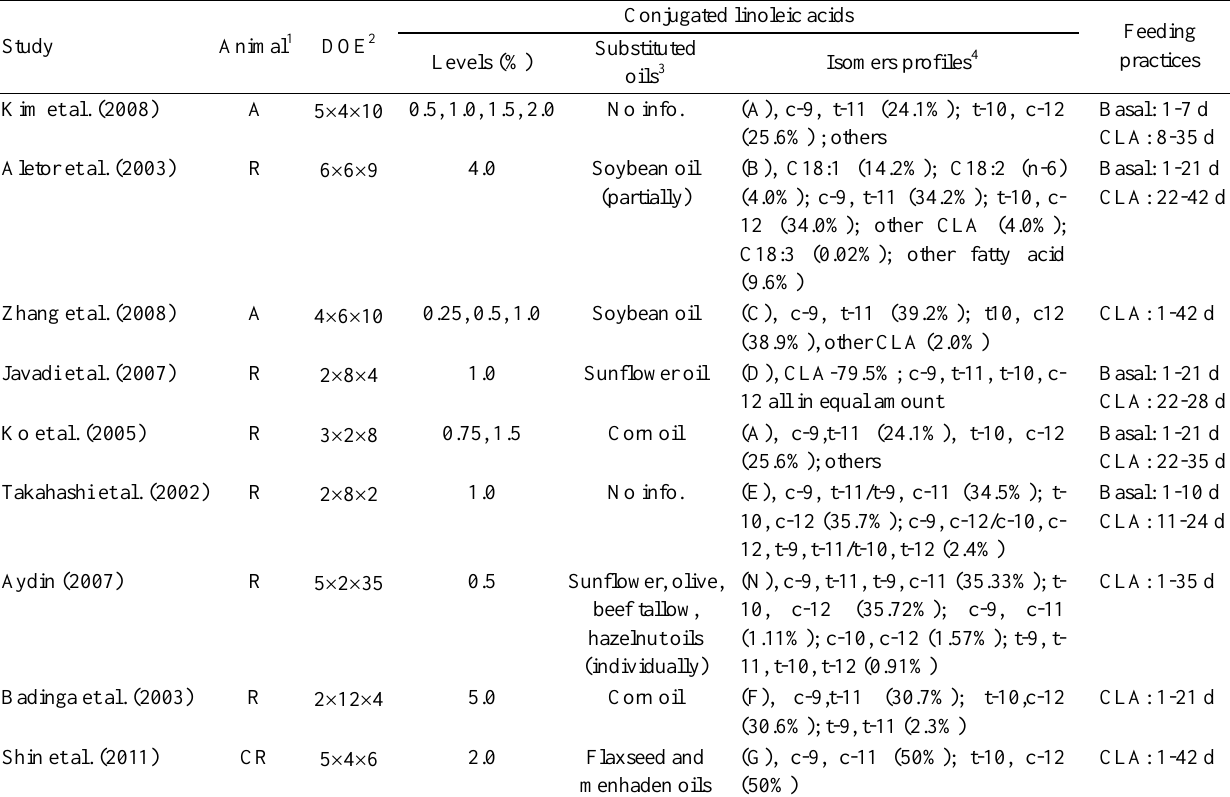
Table 1. Studies used in data sets and their information for feeding trials Study Animal 1 DOE 2